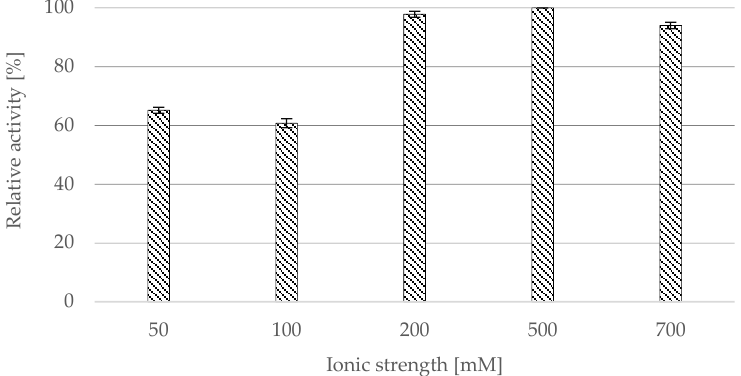
Figure 4. Effect of buffer ionic strength on CRL-OF relative activity. Reaction conditions: immobilized CRL-OF onto Octyl-Sepharose CL-4B (50 mg), phosphate buffer (100 mM, pH 7.4), the emulsion of gum Arabic and olive oil, temperature 37 °C, incubation 30 min. Data are presented as means ± standard deviations of three analyses ( n = 3). The error bars represent the standard deviations of the mean.